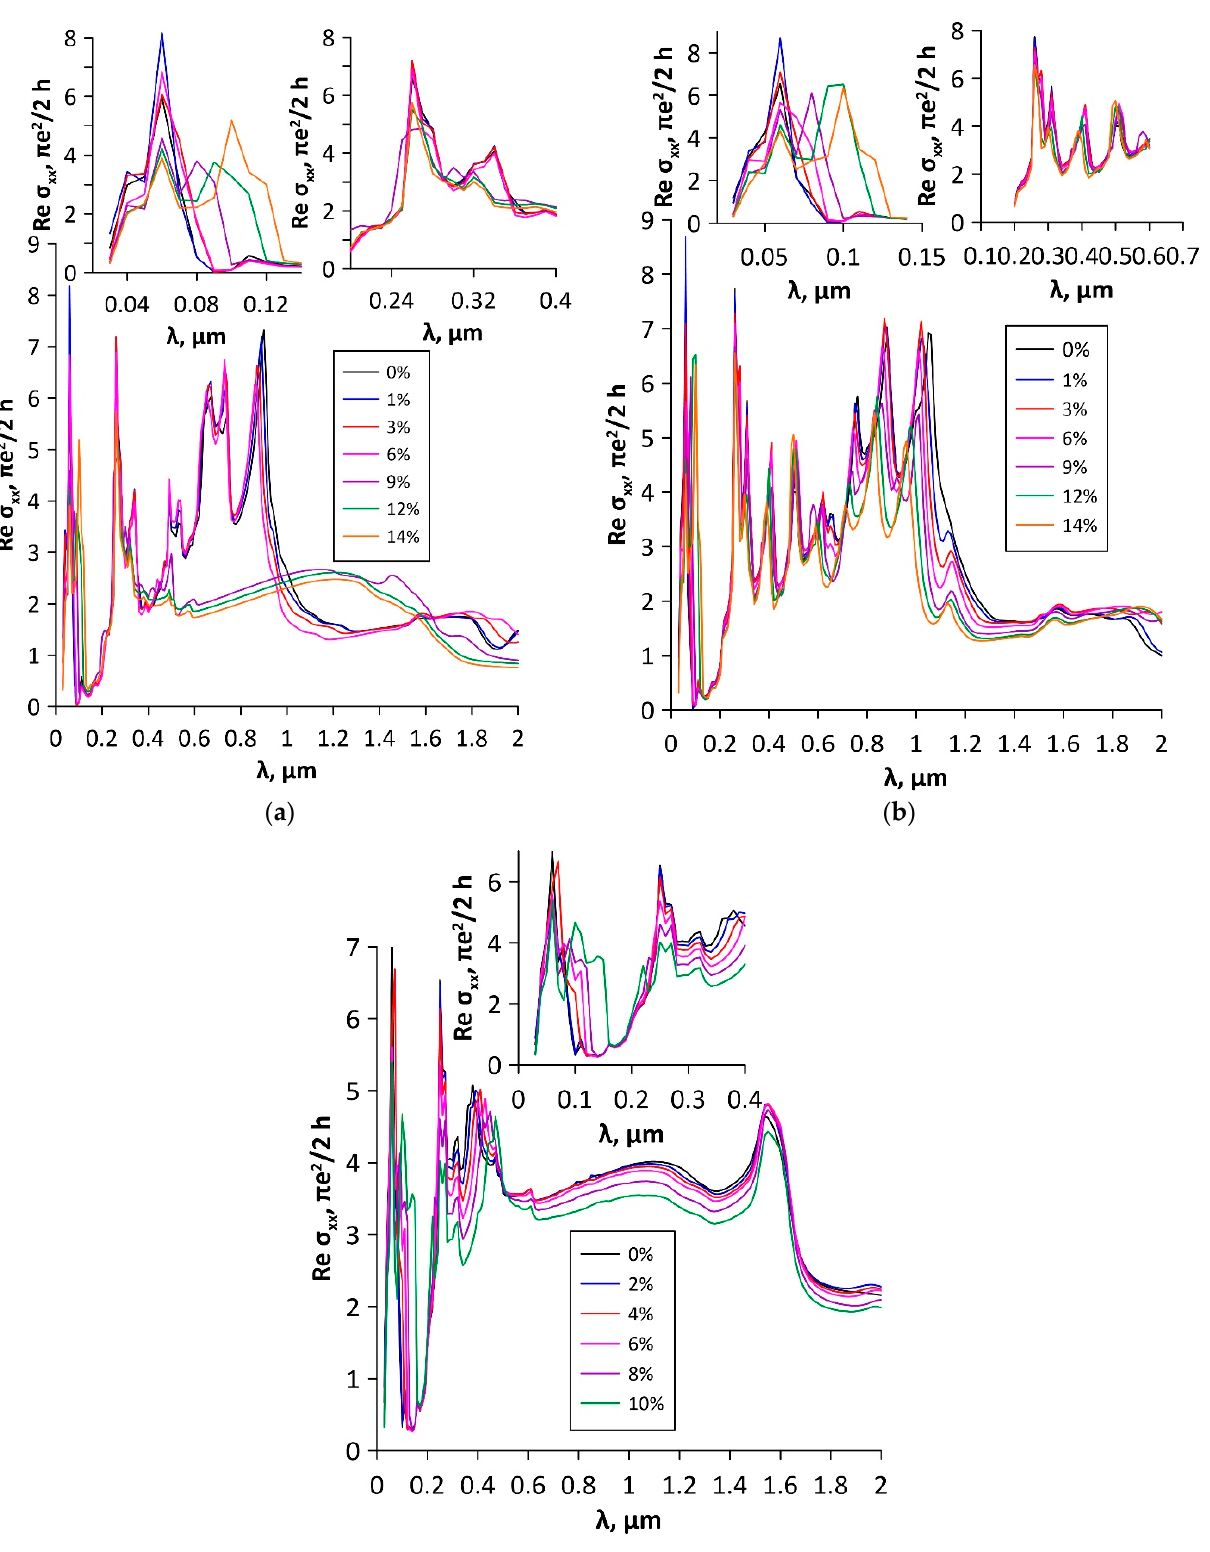
Figure 6. Profiles of the real part of the diagonal element σ xx of the optical surface conductivity tensor of a graphene-SWCNT (12,6) composite film upon axial tensile: ( a ) model V1; ( b ) model V2; ( c ) model V3.